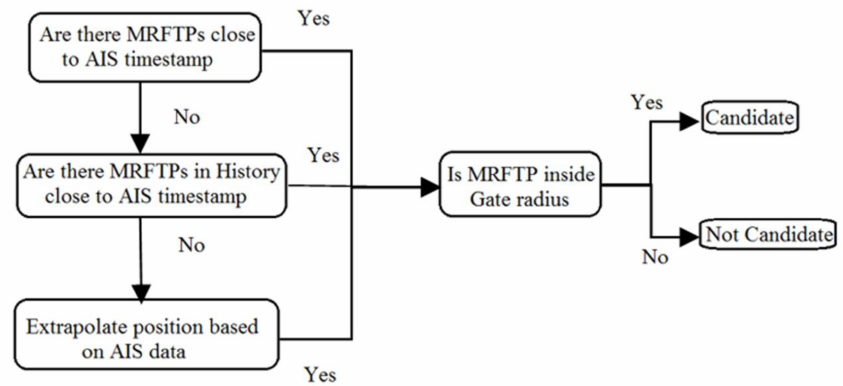
Figure 3. Step 2 of AIS-MRFT integration algorithm—Search for